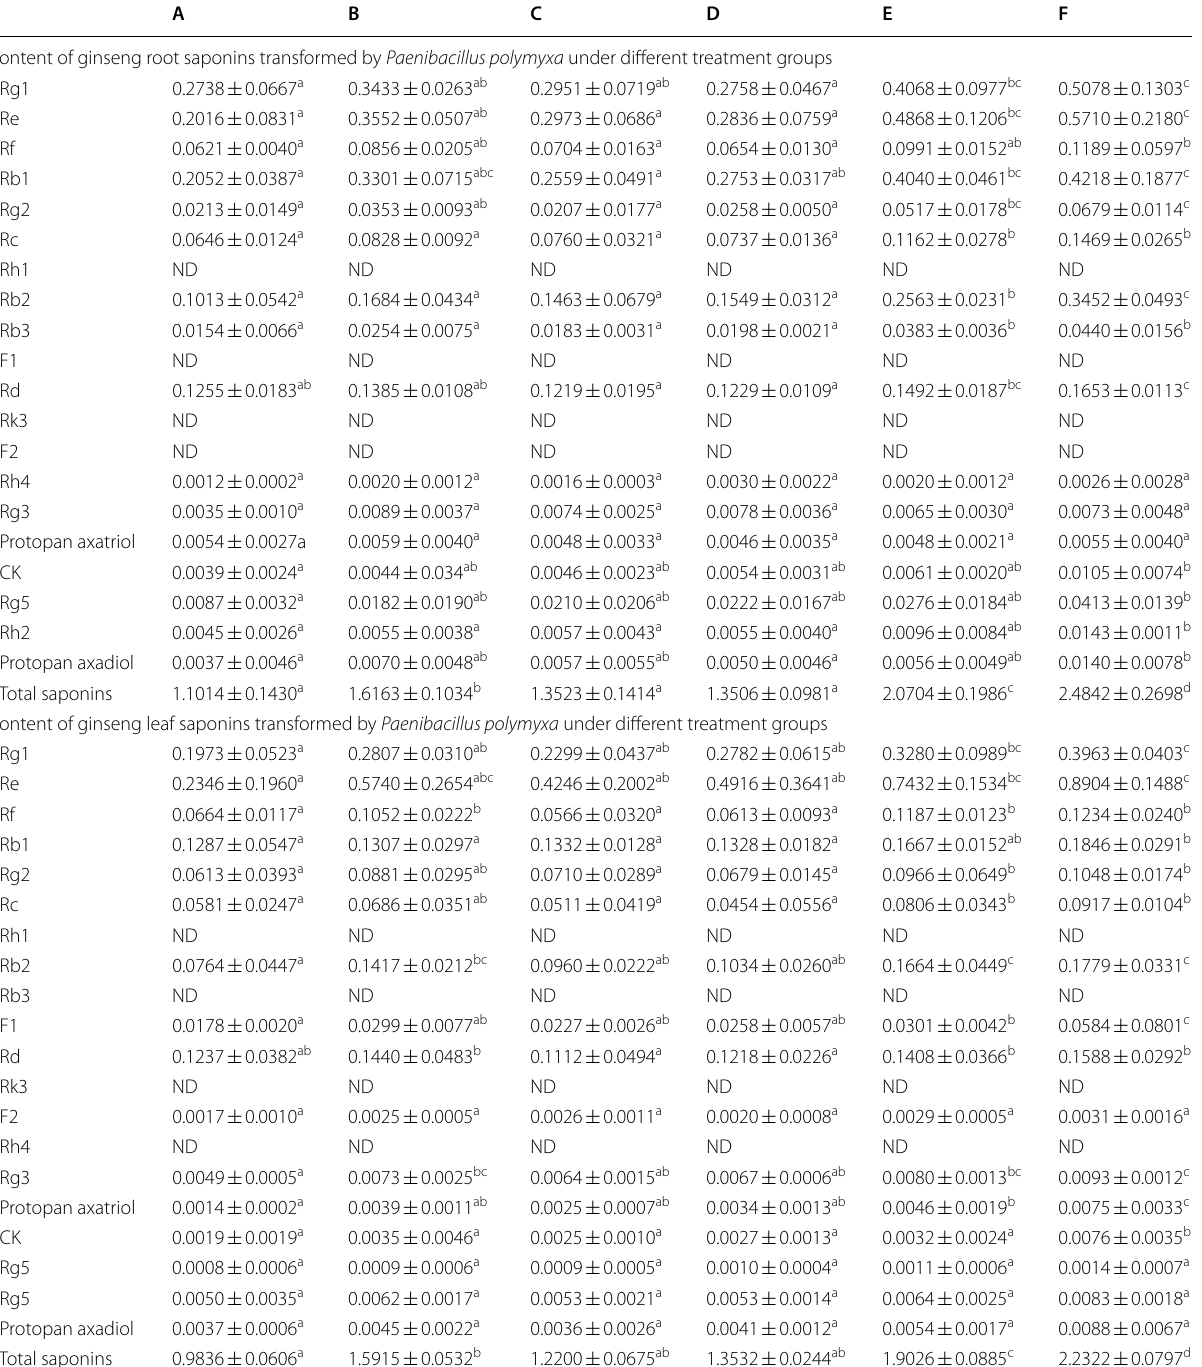
Table 3 Changes of the content of ginseng root and leaf saponins transformed by Paenibacillus polymyxa under